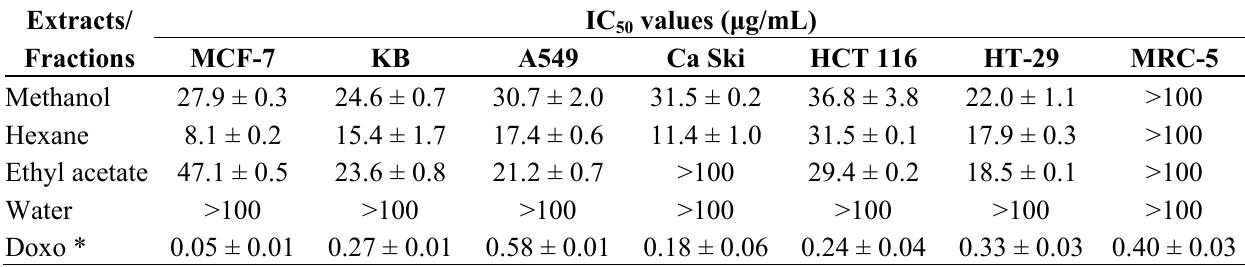
values) of extracts and fractions of C. mangga against Table 1. Cytotoxic activity (IC 50 human cancer and non-cancer cell